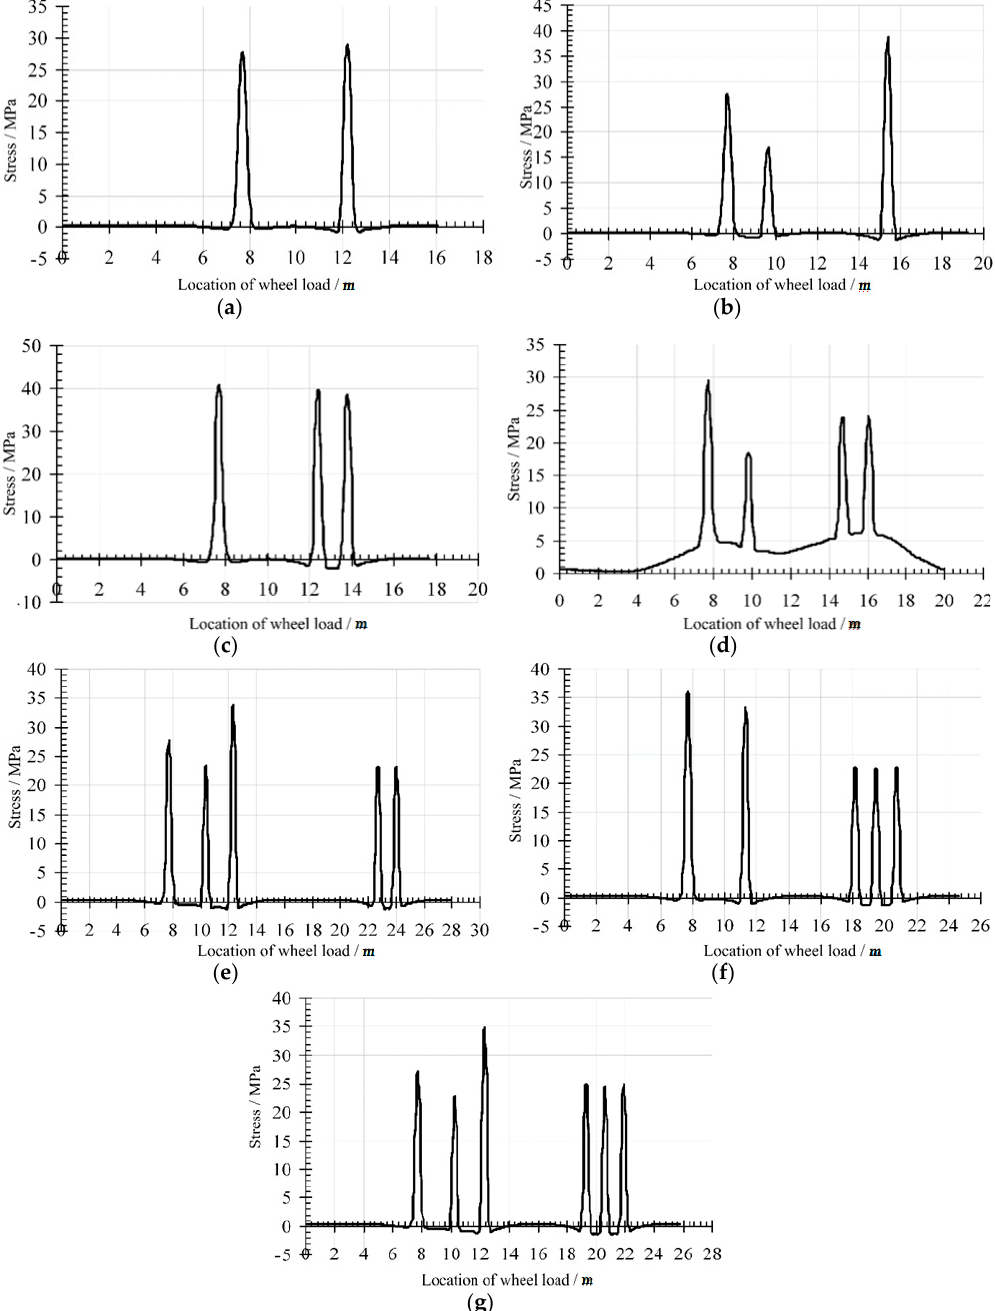
Figure 12. The stress-time curve of concerned point by various vehicles load: ( a ) Vehicle model V1; ( b ) Vehicle model V2; ( c ) Vehicle model V3; ( d ) Vehicle model V4; ( e ) Vehicle model V5; ( f ) Vehicle model V6; and ( g ) Vehicle model V7.